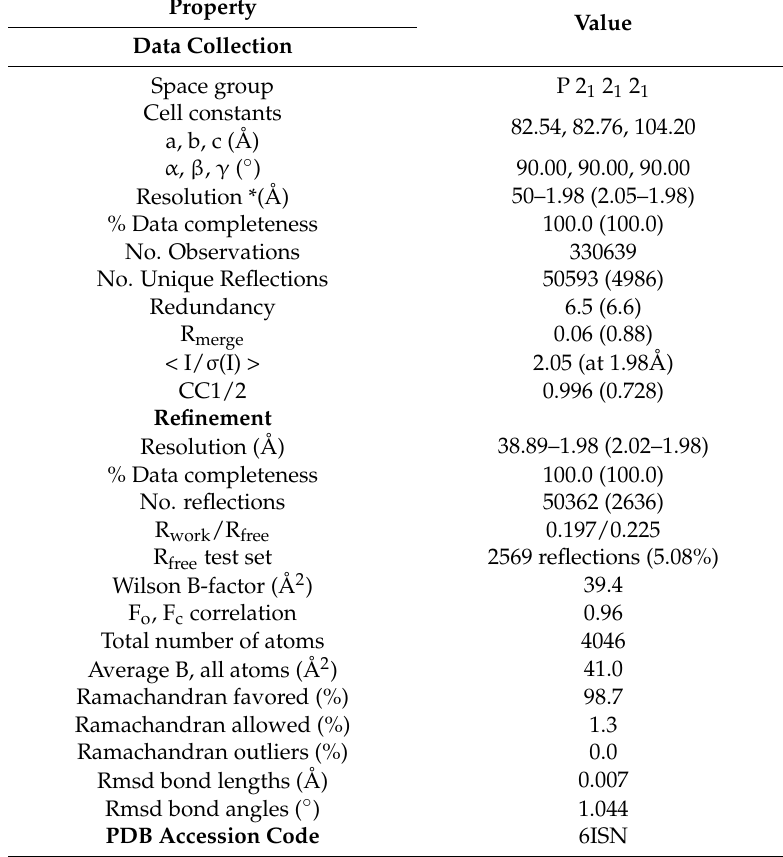
Table 5. Data collection and refinement